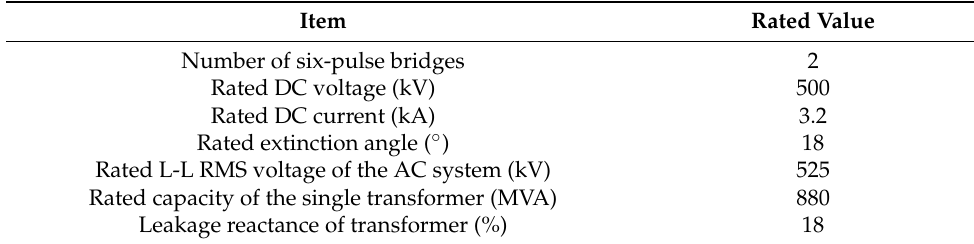
Table A1. Rated operating parameters of LCC-HVDC.